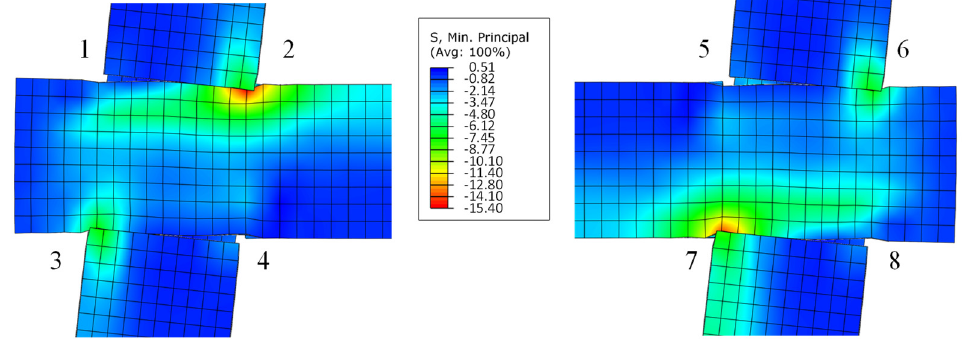
Figure 11. The minimum principal stress of the joints when the displacement = + 180 mm.